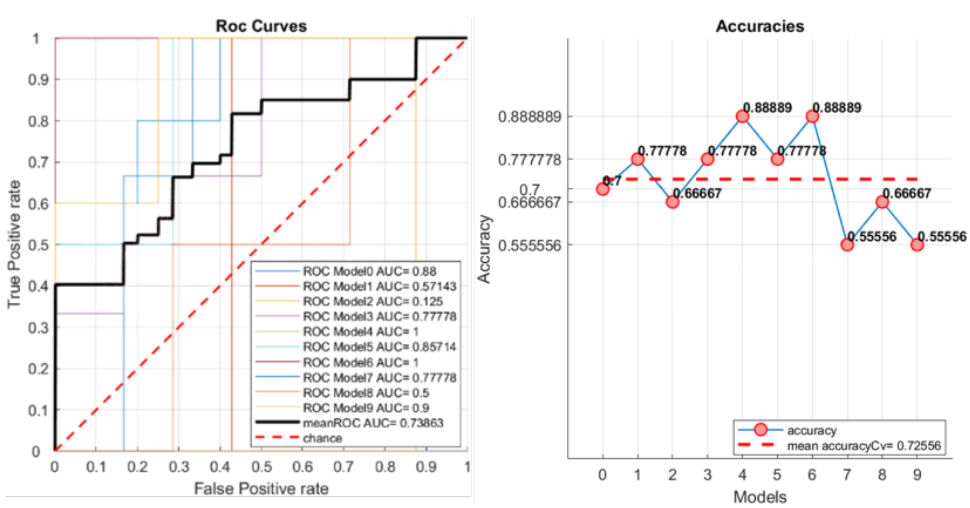
Figure 12. ROC curves and accuracies examples for the non-harmonized group.